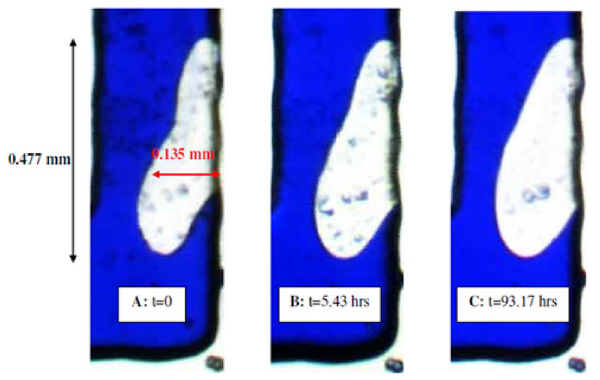
Fig. 6 A magnified image of the micro-model demonstrates two dif- ferent conditions of wettability: a more oil wet after WI and b less oil Fig. 4 Oil swelling due to CO 2 diffusion through CW into oil phase wet after CWI (Sohrabi et al. (Sohrabi et al. 2008)